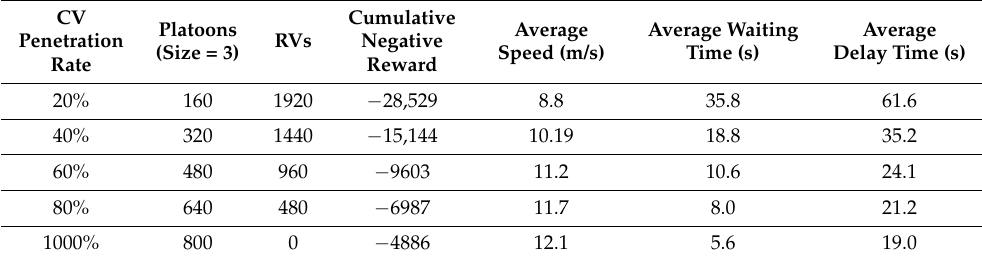
Table 5. Traffic simulation results with different CV penetration rates.